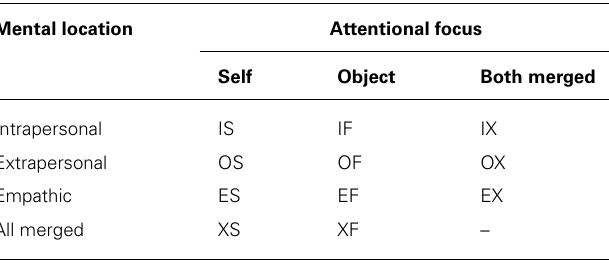
Table 3 |A matrix showing the indices for 11 conditions of various foci and locations. Mental location